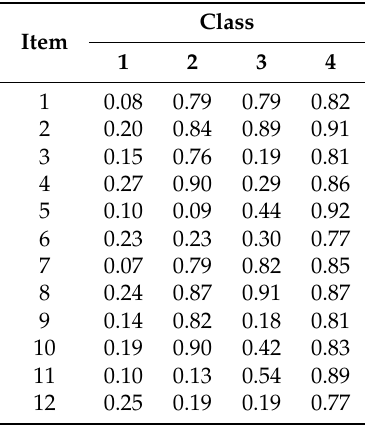
Table 4. Data illustration dichotomous data: estimated item response probabilities in the regularized latent class model (RLCM) with C = 4 classes based on the minimal Bayesian information criterion (BIC) ( λ = 0.21).